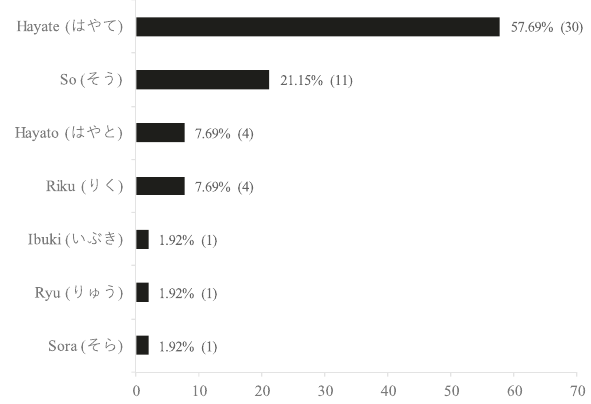
Fig. 4 Variations in readings of the name 颯 . Scores indicate relative frequencies of each reading among the sample ( n = 52). Scores in parentheses indicate the absolute frequencies of each